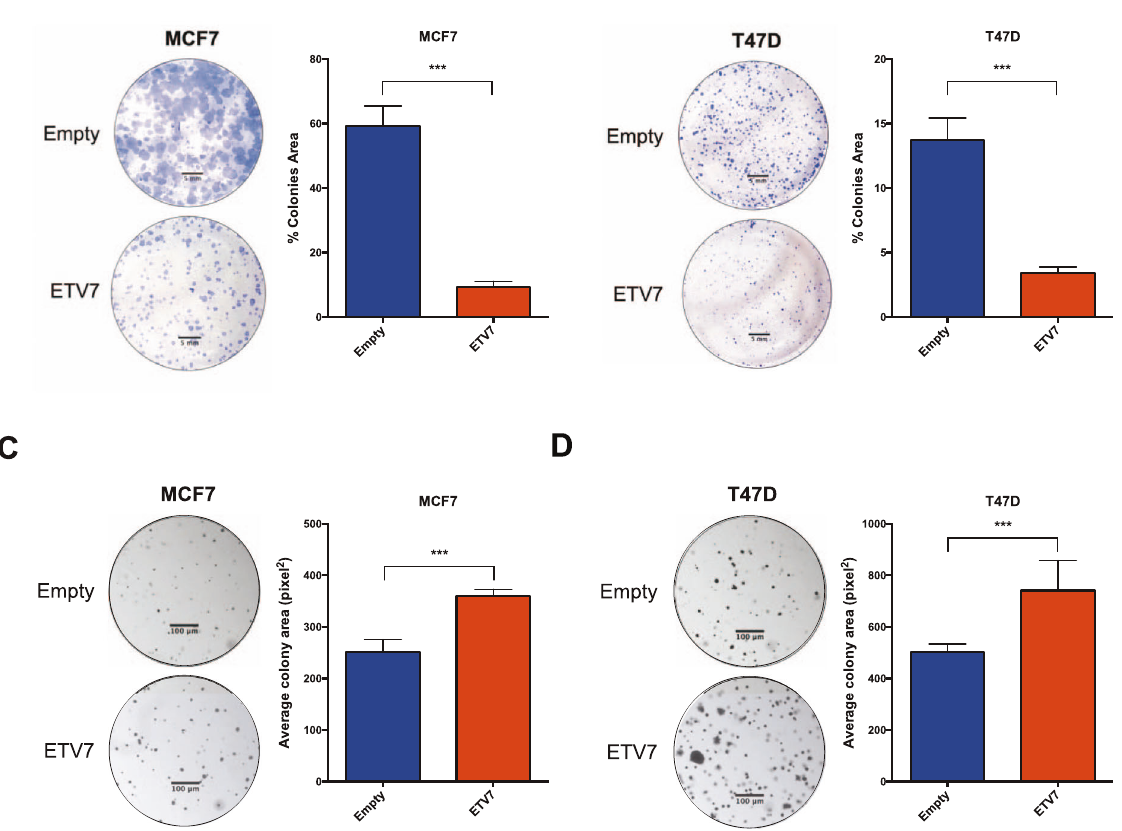
Fig. 2 Breast cancer-derived cells over-expressing ETV7 display altered proliferative potential. A , B Colony formation/clonogenic assay of MCF7 ( A ) and T47D ( B ) Empty and ETV7 cells after 3 weeks of growth. Presented are a representative image (left) of the entire well and the total colony area (right), calculated with the ImageJ software. C , D Soft agar colony formation assay of MCF7 ( C ) and T47D ( D ) Empty and ETV7 cells after 3 weeks of growth. On the left, a representative image of part of the well (taken at ×5 magni fi cation) and on the right the average colony area calculated with the ImageJ software. Indicated are the scale bars for microscopy images. Bars represent the averages and standard deviations of at least three independent experiments. *** p -value <